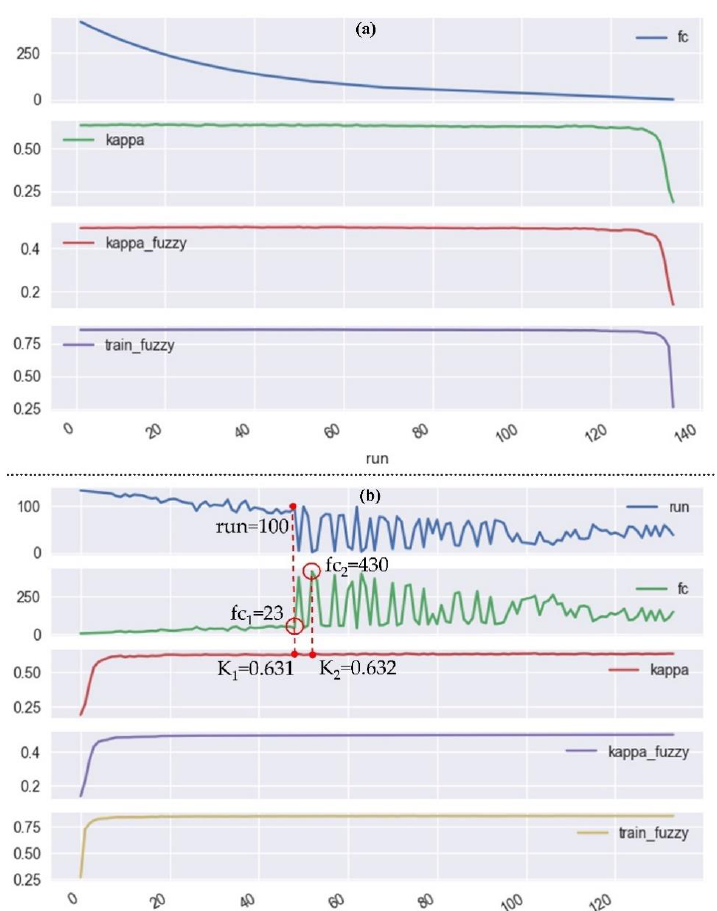
Figure 6. Example of a recursive feature elimination (RFE) report produced when running random forest (RF) classification on the 430 SR bands. Results are sorted by classification run sequences ( a ) and by Kappa values ( b ). The blue line (fc) shows the steady decrease in number of features (from 430 to 0 in this case) used for classification, while the green and red lines represent the produced Kappa and fuzzy Kappa respectively for each run sequence.